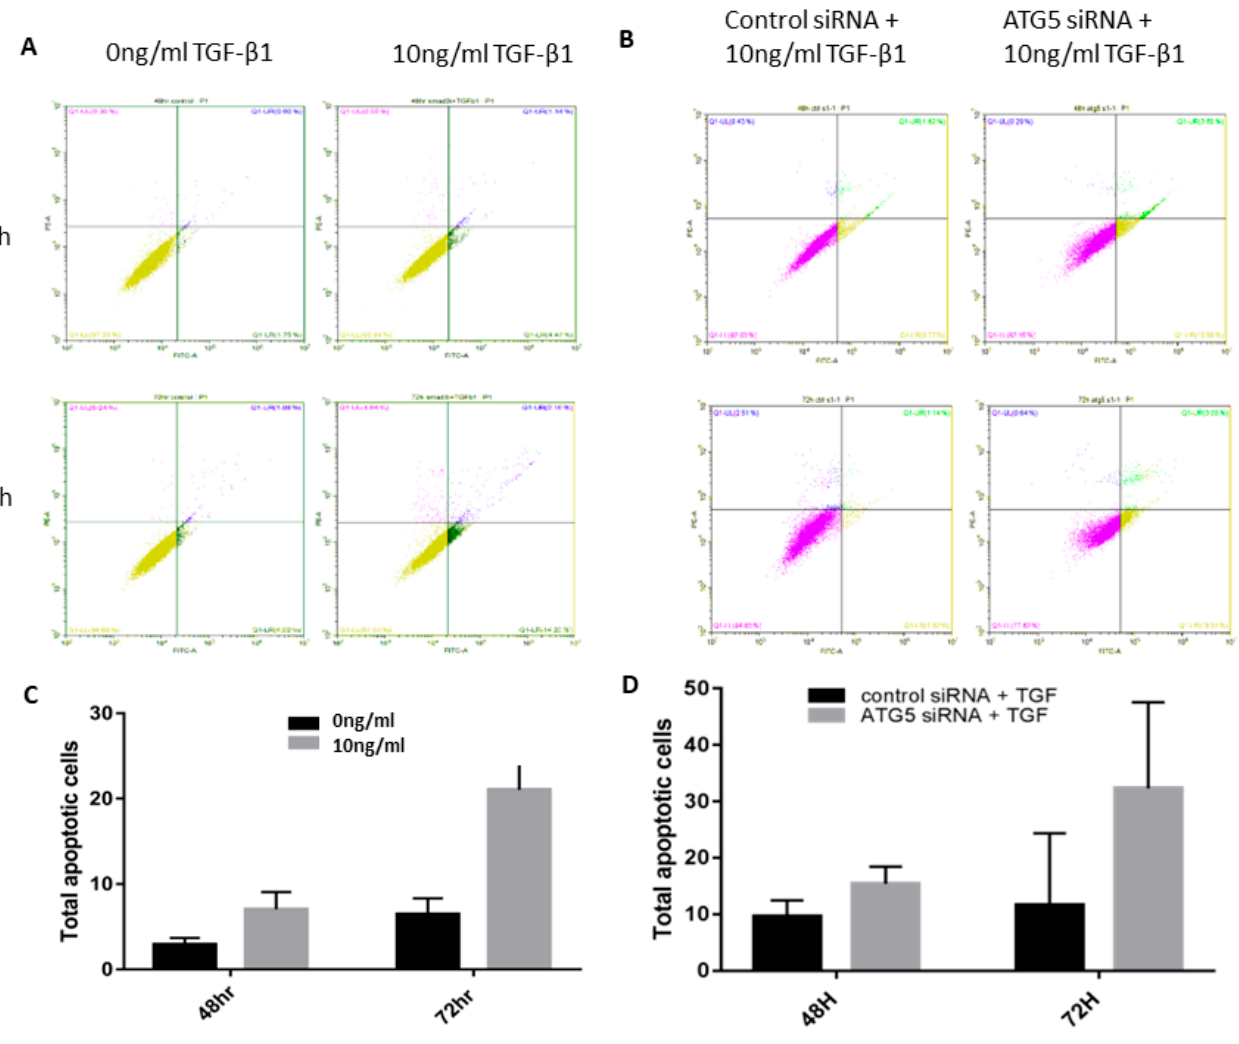
Figure 3. Apoptosis is regulated by ATG5 in HTM cells. HTM cells were treated with TGF- β 1 (10 ng/mL) and siRNA and the total number of apoptotic cells was calculated by flow cytometry. ( A – D ) The total number of apoptotic cells in TGF- β 1 treated and siRNA knockdown HTM cells. 3.4. TGF Induced Autophagy Involves a Positive Feedback Loop of ATG5 on the TGF Pathway As shown in Figure 4, Smad3 inhibitor-treated cells had lower levels of autophagy proteins ATG5 and LC3-II. This also paralleled with reduced Smad3 protein levels in si ATG5 transfected cells confirming that ATG5 regulates TGF- β 1 induced EMT and fibrosis in HTM cells via a positive feedback loop of ATG5 involving TGF- β 1 and SMAD signaling and downstream